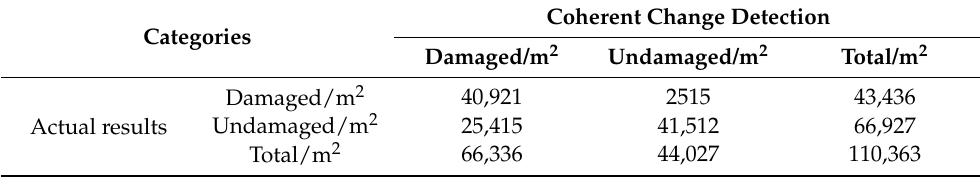
Table 2. Accuracy verification of coherent change